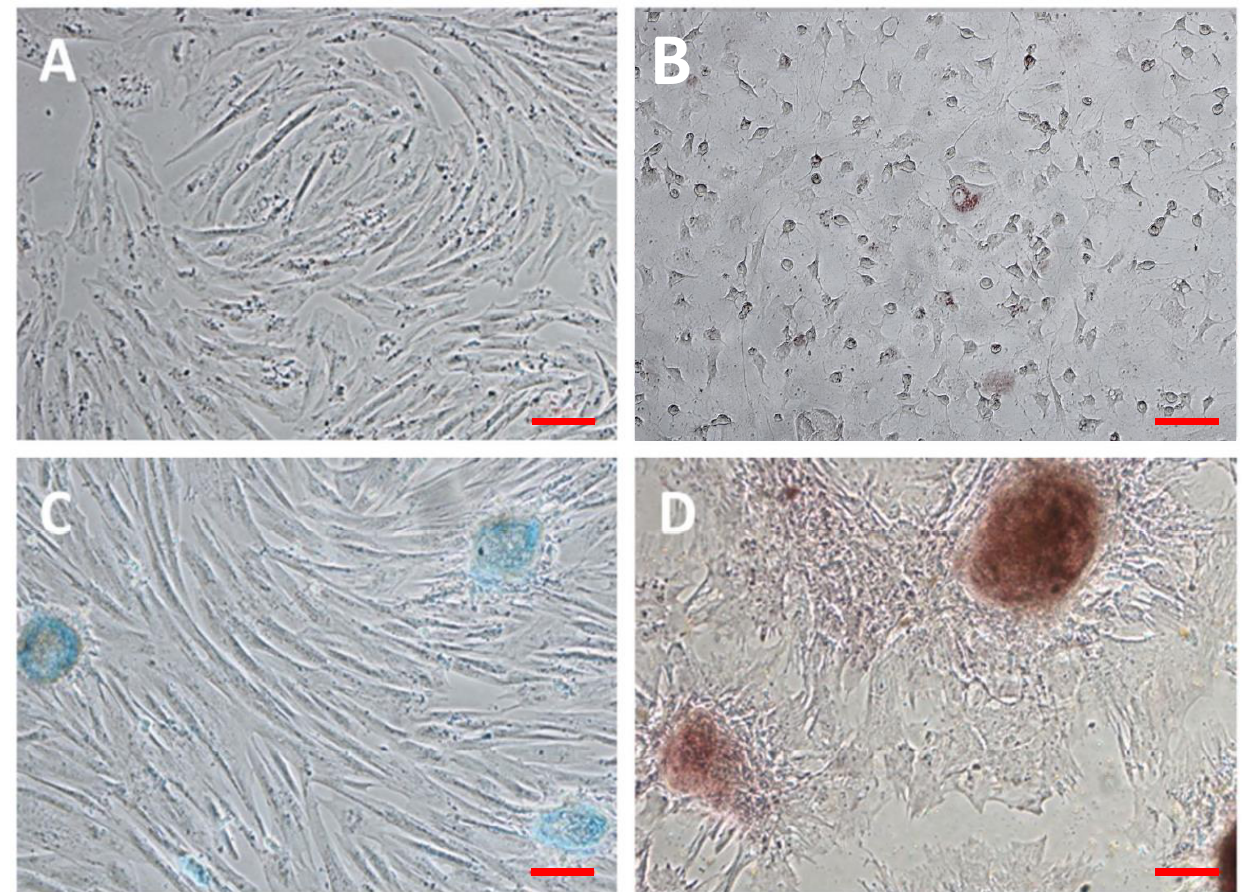
Figure 1. Adipose-derived mesenchymal stem cells ( A ) and their adipogenic ( B ), chondrogenic ( C ) and osteogenic ( D ) differentiations. The differentiations were induced as described in material and methods section. Microscopy images of in vitro differentiations at 10× magnification. Scale red bars detail 100 µm. Table 2. Mean and standard deviation of the clinical indices CIBDAI and CCECAI, albumin, cobal- amin and the prednisone dose (mg/kg/day) in the MSC and P-MSC groups. Significance level ( p -value) between the MSC and P-MSC